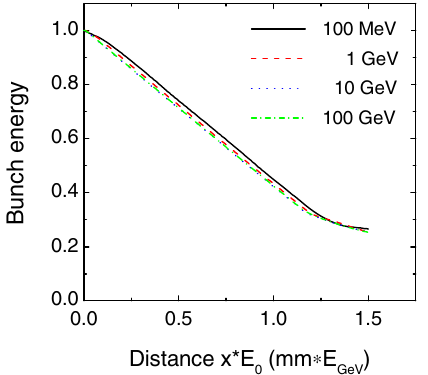
FIG. 1. Collective deceleration and its saturation. The relative decrease of total bunch energy is given versus scaled propagating distance for different initial bunch energies E 0 : 100 MeV, 1 GeV, 10 GeV, and 100 GeV. The plasma density is n e ¼ n b = 5 (cid:4) 1 : 1 (cid:3) 10 19 cm (cid:1) 3